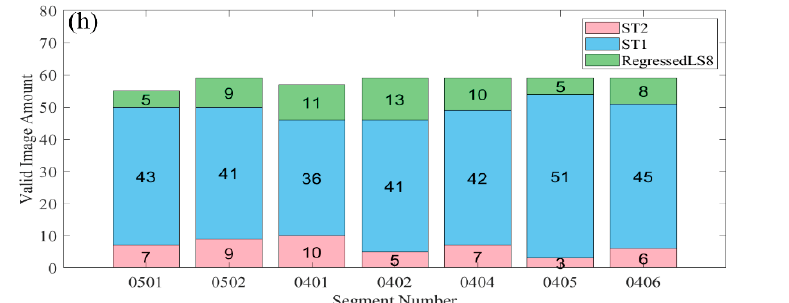
Figure 3. Calculated flow sequences of each segment. In the figure, subfigure ( a – g ) represent sections 0501, 0502, 0401, 0402, 0404, 0405 and 0406, respectively. In each sequence, red circles represent ST2 images, cyan meter characters stand for LS8 original images, blue crosses for ST1 radar images, and green triangles for LS8 regressed images. The dark square dotted line represents the composited flow sequence after adjustment. Subfigure ( h ) each column represents the number of composited flow values and the component source of the section. Green represents data from LS8 regressed images, blue from ST1 radar images, and red from ST2 optical images. The number of specific sources is marked in the corresponding color